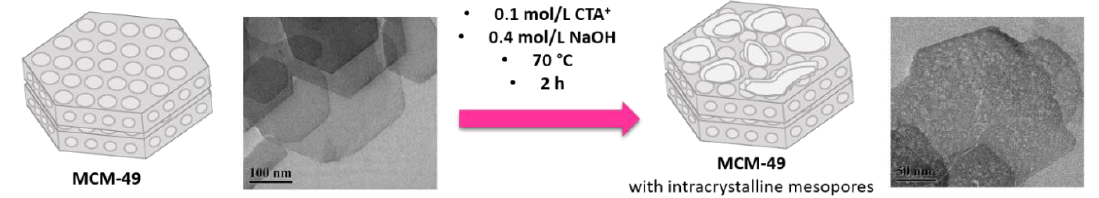
Figure 7. Post-synthesis treatment to obtain intracrystalline mesopores in MCM-49 zeolite. TEM micrographs were taken from Reference [58]. Copyright (2015), with permission from